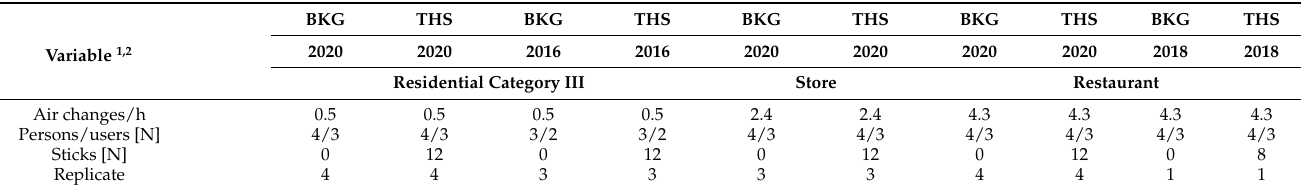
Figure 2. Comparison of the concentrations of airborne acetaldehyde (µg/m 3 ) in the background (BKG) and THS 2.2 use sessions (THS) under simulated ( a ) Residential category III (0.5 h −1 ), ( b ) Store (2.4 h −1 ), and ( c ) Restaurant (4.3 h −1 ) environ- ments.